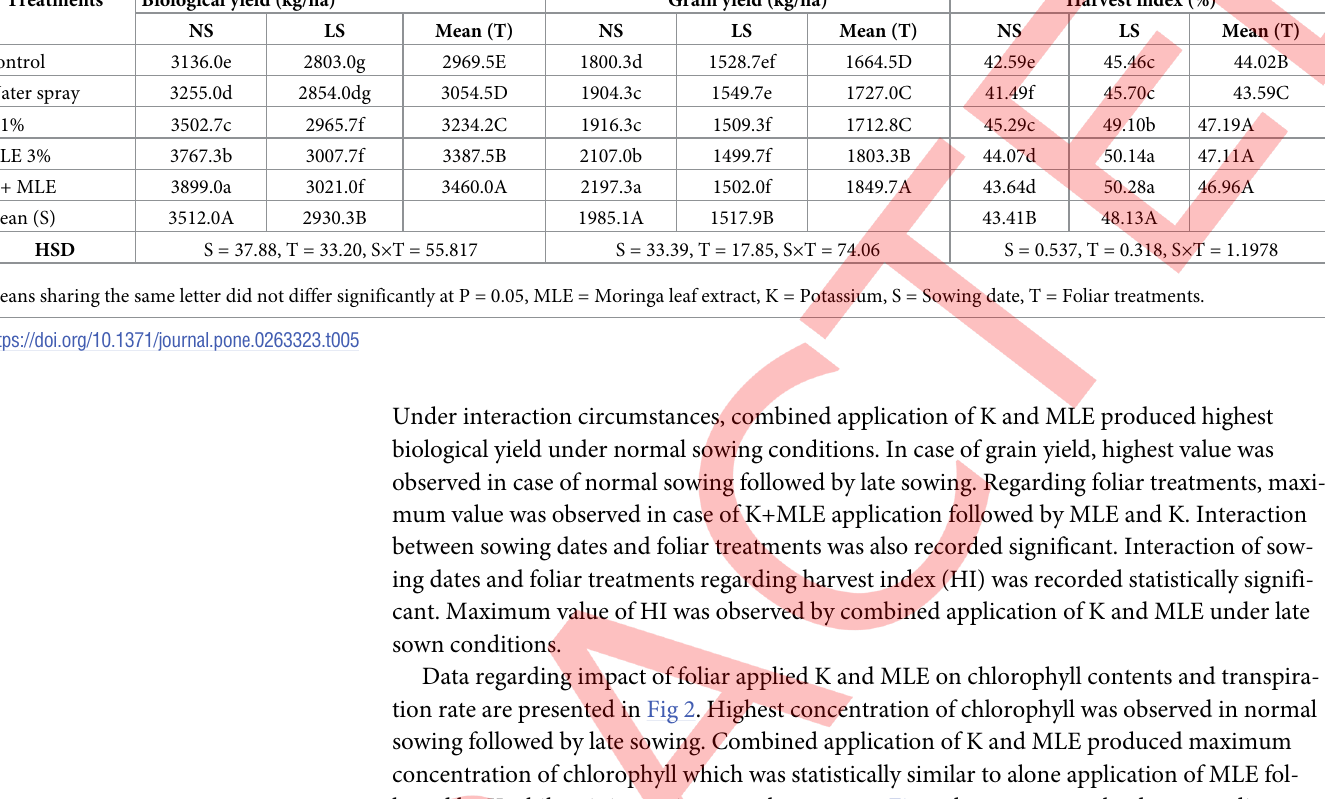
Table 5. Impact of foliar applied potassium and moringa leaf extract on biological yield (kg/ha), grain yield (kg/ha) and harvest index of normal and late sown kabuli chickpea. Treatments Biological yield